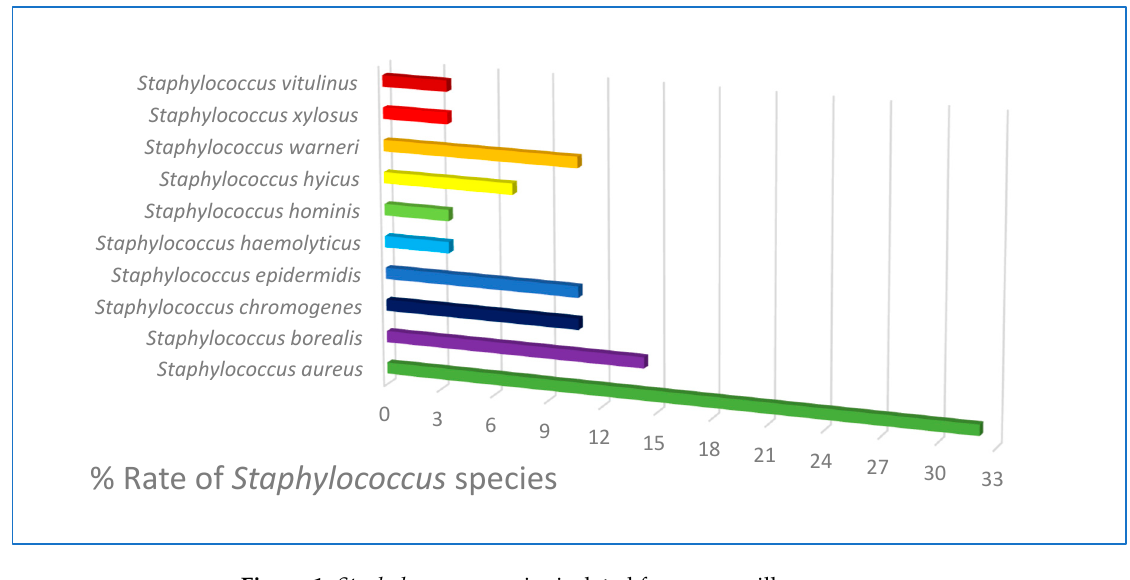
Figure 1. Staphylococcus species isolated from raw milk.